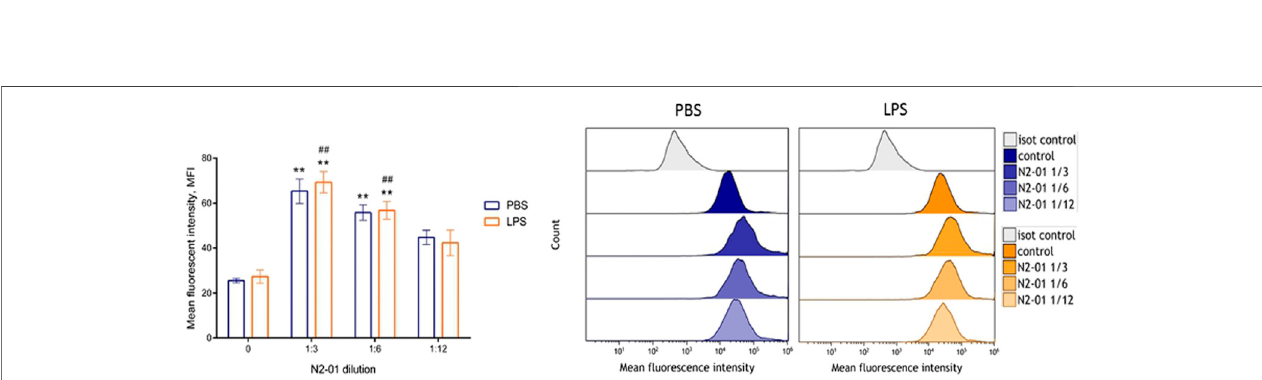
FIGURE 4 | The effect of N2-01 on NO production by the human umbilical endothelial cells. Note. Statistical assessment of differences was performed using ANOVA ( p < 0.001), and pairwise comparison of the mean values was performed using the Tukey HSD test. Data are expressed as mean ± standard error of the mean (SEM) of at least four individual experiments ( n (cid:2) 4). The differences are signi fi cant: ** p < 0.01 vs PBS; ## p < 0.01 vs LPS.